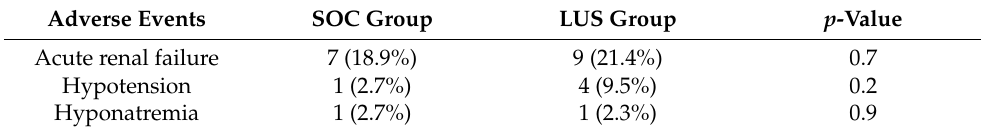
Table 4. Study adverse